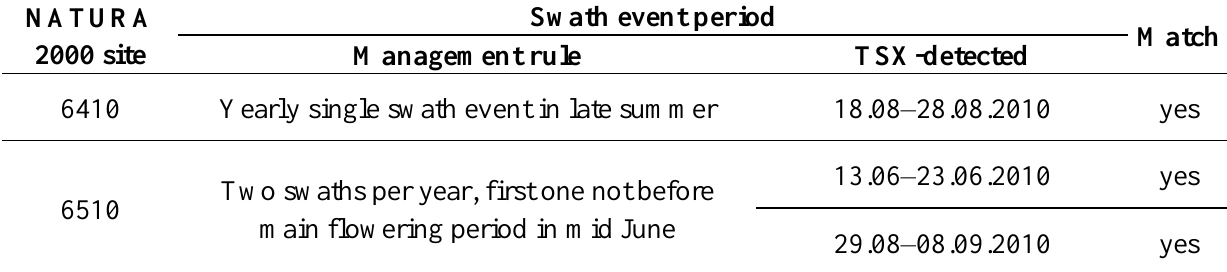
Table 3. Comparison of the swath event periods derived from TerraSAR-X to the NATURA 2000 habitat-specific swath management